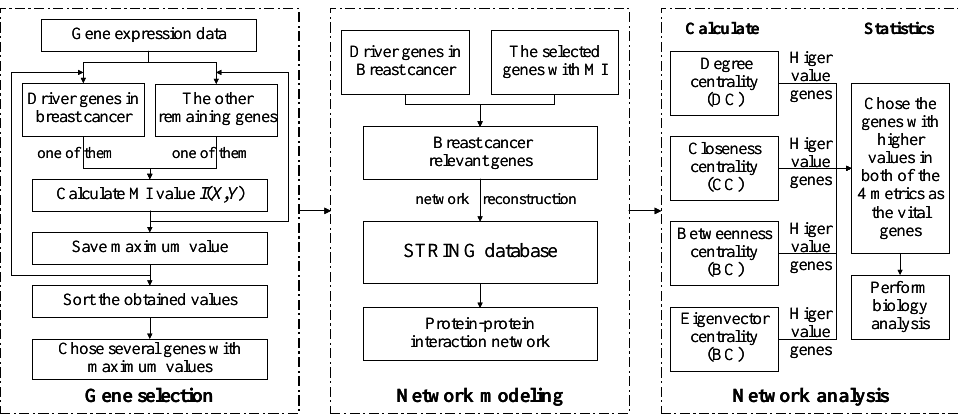
Figure 1. The process of the method. The three steps of the process are breast cancer gene selection, protein–protein interaction network modeling, and network